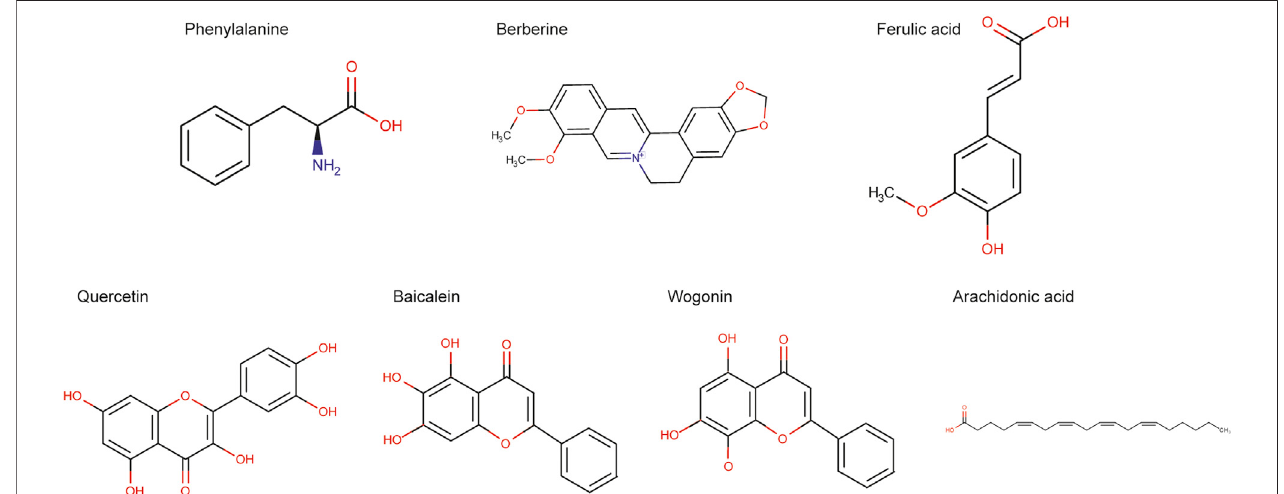
FIGURE 7 | The structure of active seven